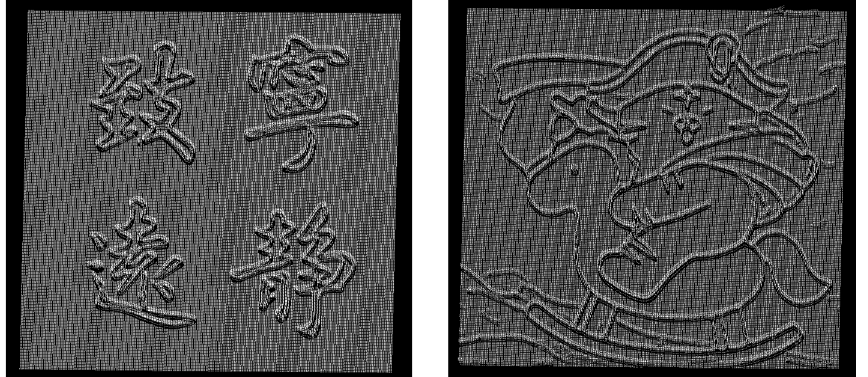
Figure 16. Image height value recovery point cloud.